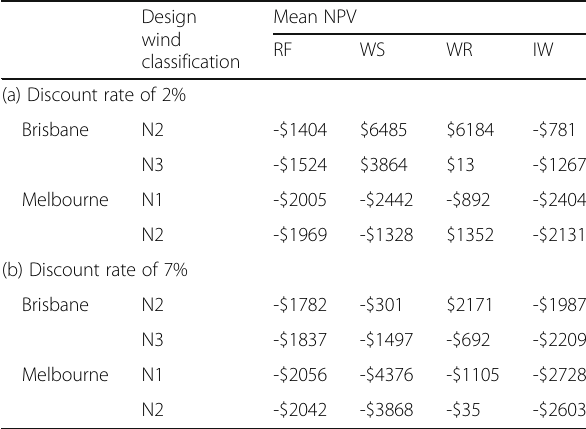
Table 10 The effect of discount rate on mean